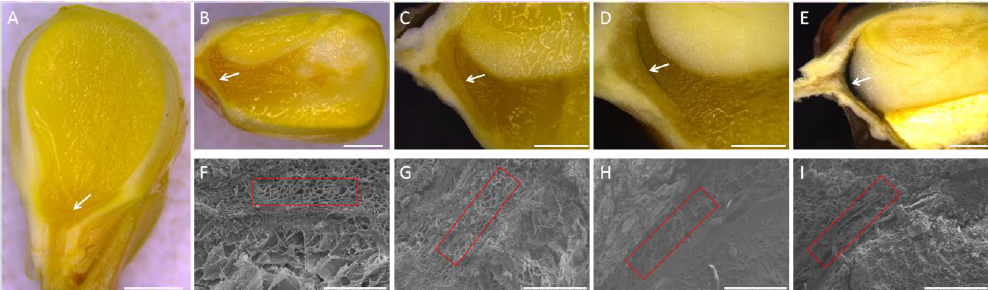
Figure 1. Observation of the black layer in maize kernels at different developmental stages. ( A – E ) Longitudinal section of maize kernels 10, 20, 30, 40, and 50 days after pollination (DAP). The arrowhead indicates the position of the black layer. Bar = 2 mm; ( F-I ) Scanning electron microscopy analysis of the black layer of maize kernels 20, 30, 40, and 50 DAP. Regions surrounded by red boxes indicate the structure of the black layer. Bar = 200 μm.